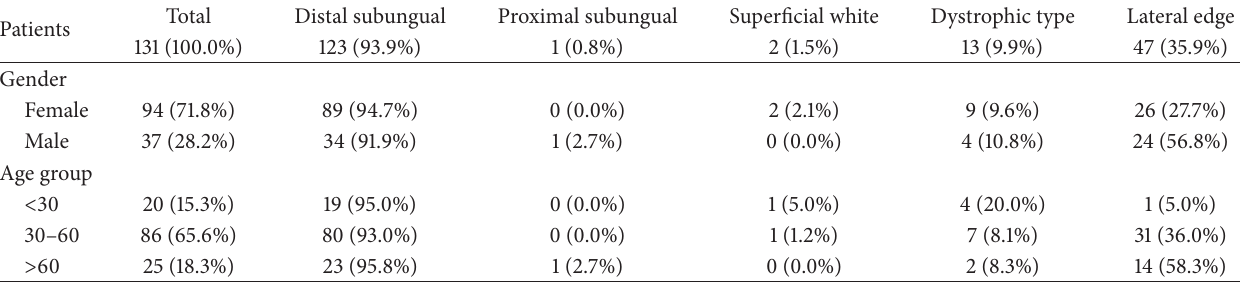
Table 1: Clinical onychomycosis types.